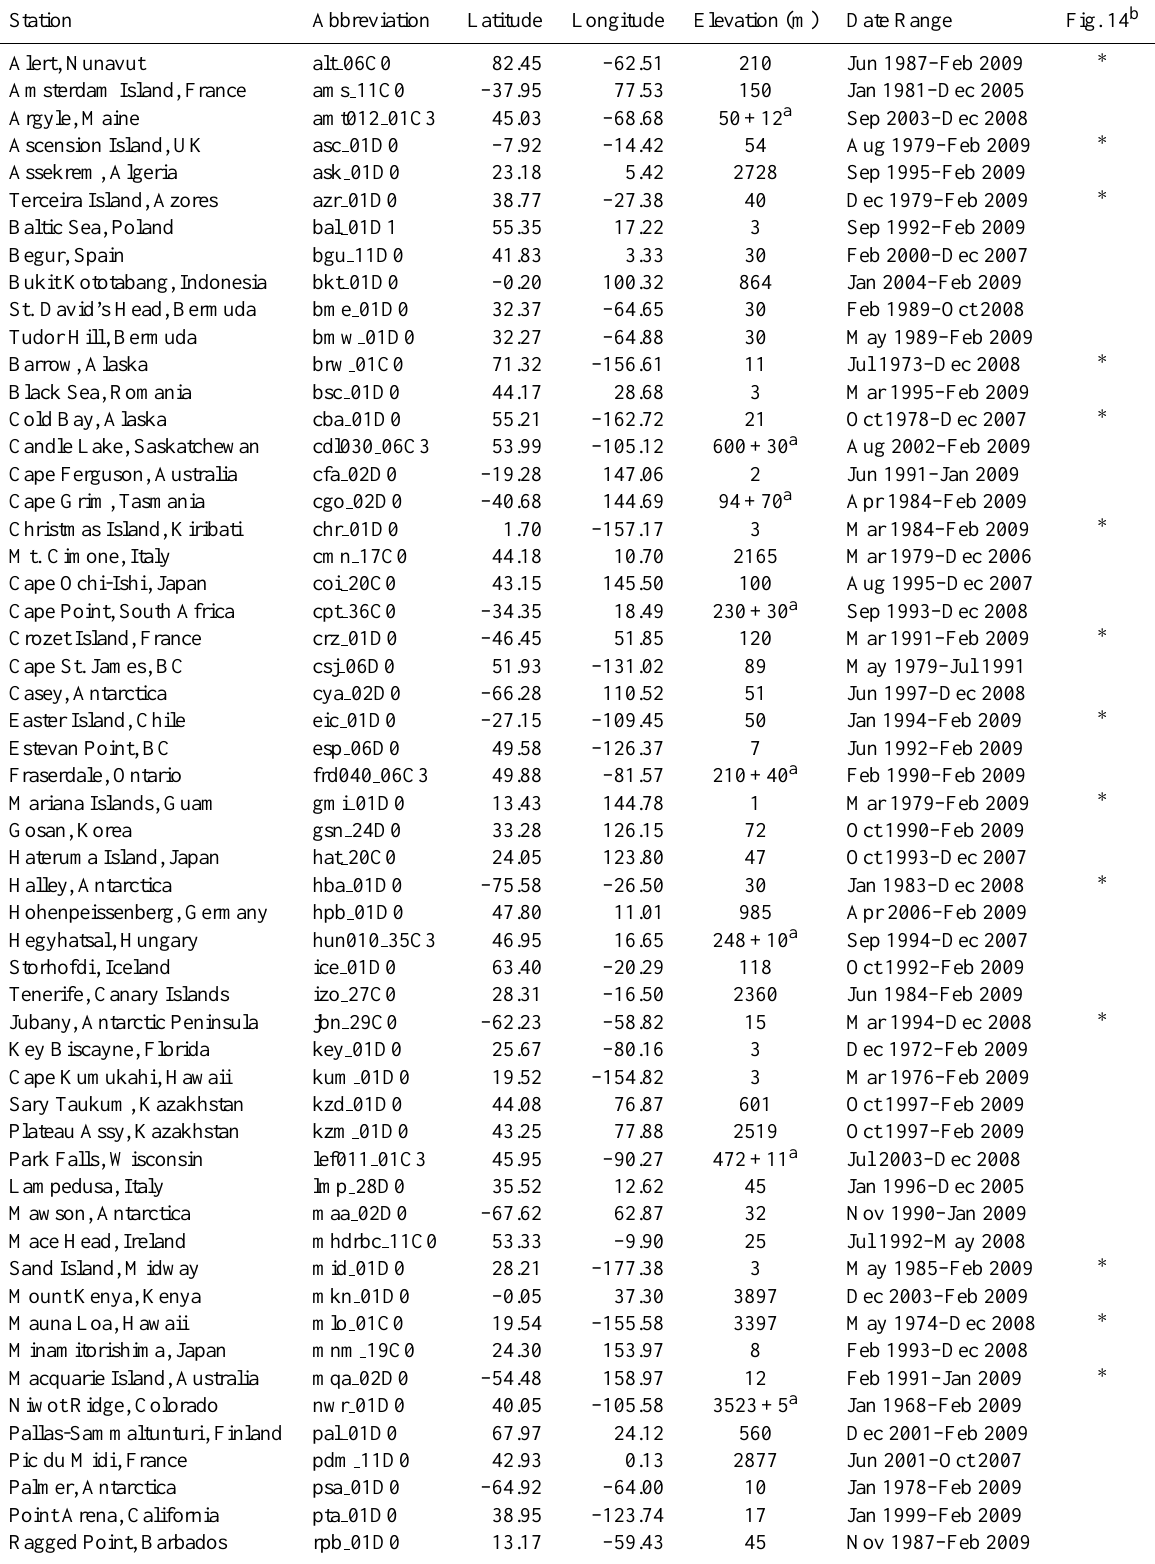
Table 3. GLOBALVIEW-CO 2 stations used for comparisons with GEOS-Chem in this work (GLOBALVIEW, 2009).